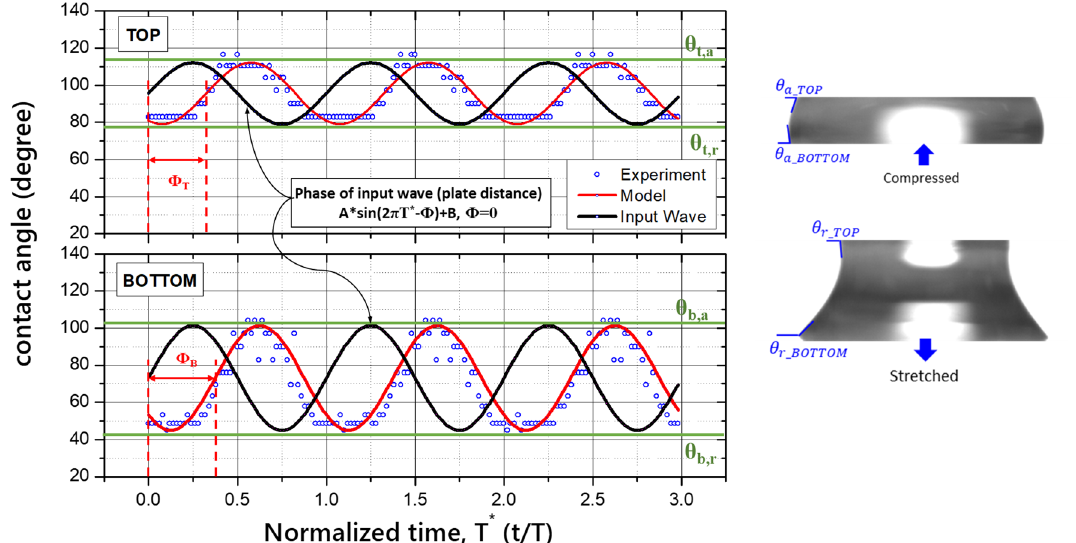
Figure 6. Measured contact angle on the top and bottom sides from the experiment according to the normalized time T* and comparison with input oscillatory